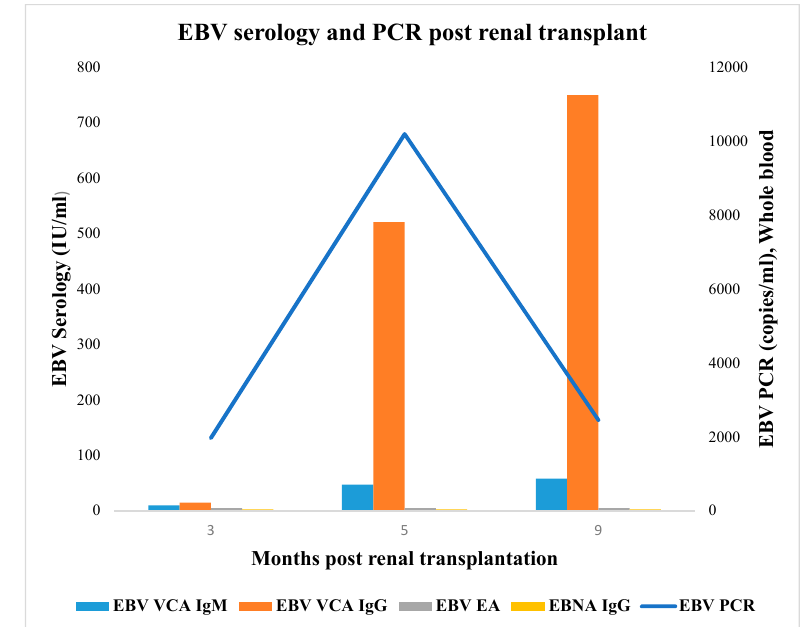
Figure 2. Timeline of Epstein–Barr virus (EBV) serology and polymerase chain reaction (PCR) post-renal transplantation. EBV serologies (viral capsid antigen (VCA) IgM, VCA IgG, early antigen (EA) and nuclear antigen (EBNA) IgG expressed in IU/mL) and EBV DNA PCR expressed in copies/mL.